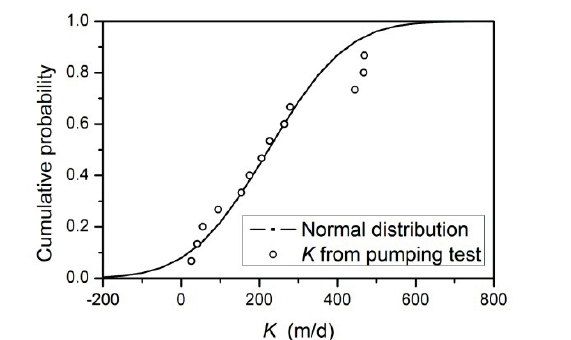
Fig. 1 The fitted curve of K estimates from pumping tests with a normal cumulative probability